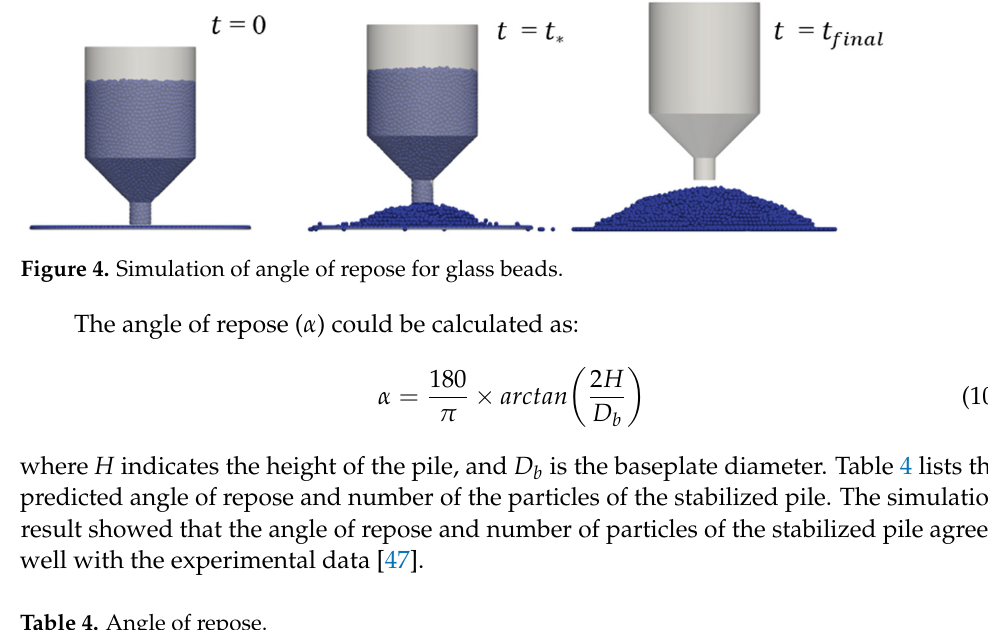
Table 4. Angle of repose.